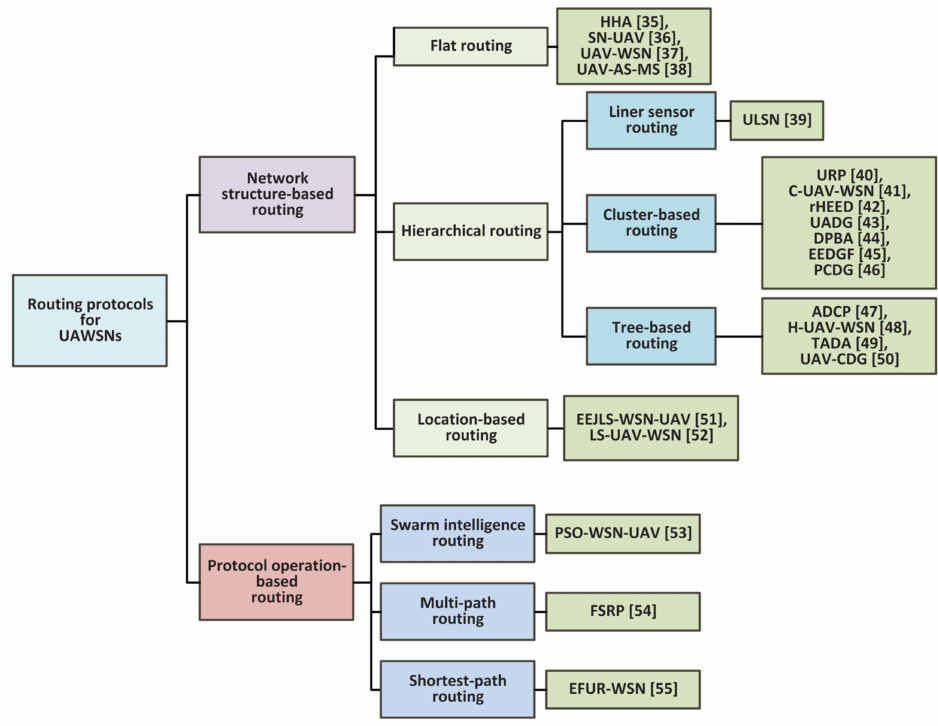
Figure 1. Taxonomy of routing protocols for